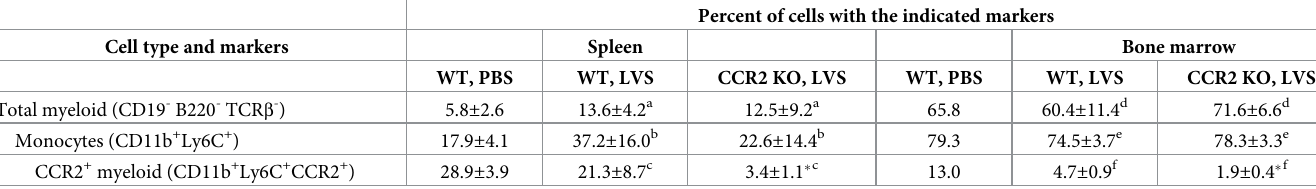
Table 1. Splenocyte and bone marrow myeloid cell subpopulations in mice infected with 10 4 LVS ID.